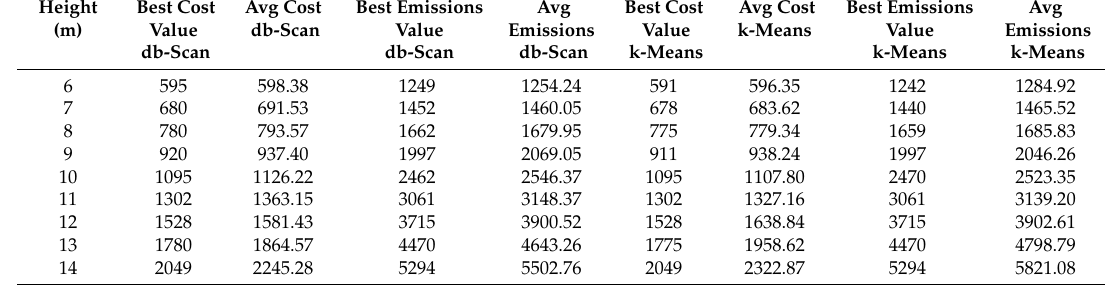
Table 6. Comparison between db-scan and k-means operators in cost and emission optimization.